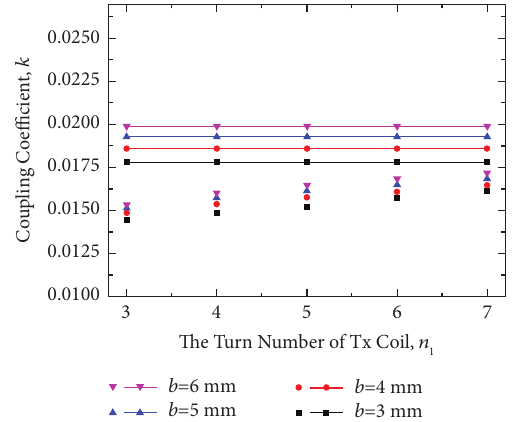
Figure 6: Simulated and analytical results of k of a WPTsystem by sweeping n 1 and b . Symbols are for simulated, while lines with symbols are for analytical, respectively. f p � 30MHz, h � 20mm, R av � 20mm, R 2 � 5 mm, r 1 � 0.287mm, and r 2 � 0.04mm.